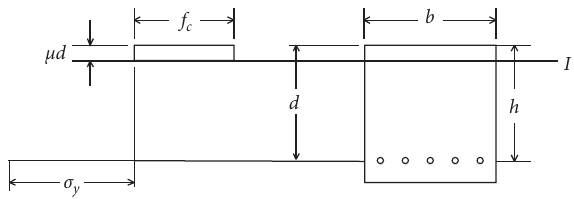
Figure 2: Area diagrams for simply supported RC beams.